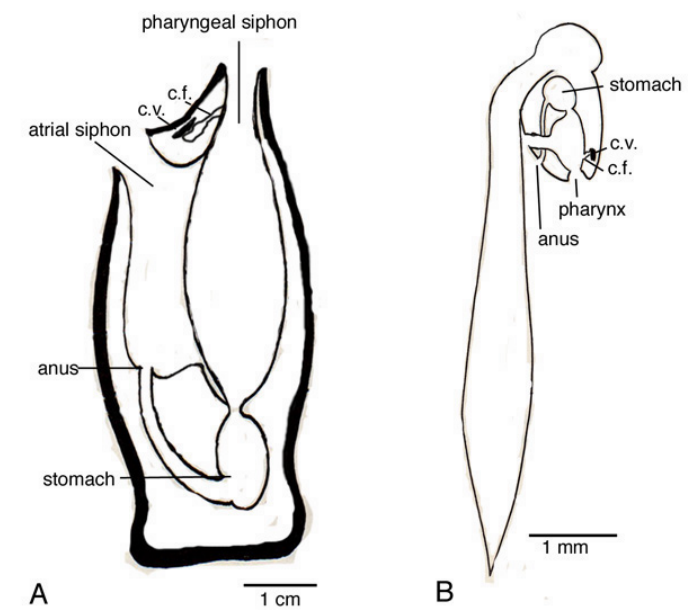
FIGURE 2 . (A) Schematic representation of a C. intestinalis adult. The chordate body plan of the embryo and larvae has been drastically reorganised during metamorphosis. Sea water enters the pharyngeal siphon (which develops from the oral primordium) and exits via the atrial siphon (which develops from the atrial primordia). The ciliated funnel (c.f.) is connected to the pharyngeal siphon and to the neural gland that lay next to the cerebral vesicle (c.v.). (B) Schematic representation of an O. dioica adult. The adults keep their larval morphology at the adult stage and possess a